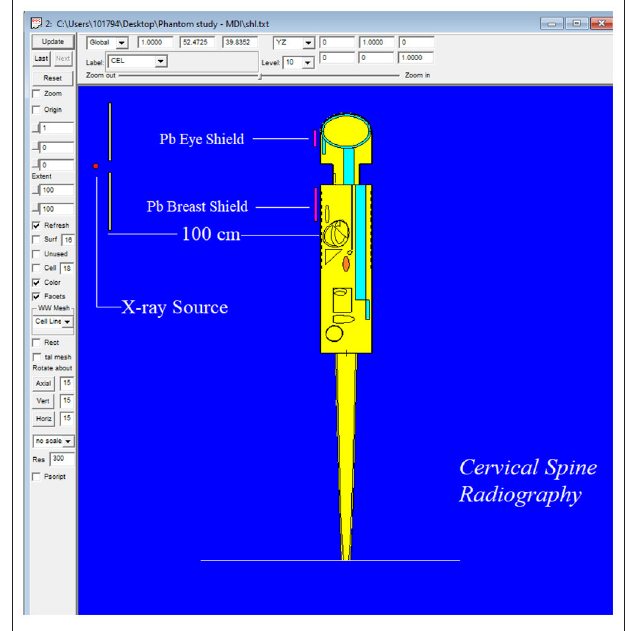
FIGURE 2 | General appearance of the modified MIRD phantom and CELL numbers of the organs and tissues.